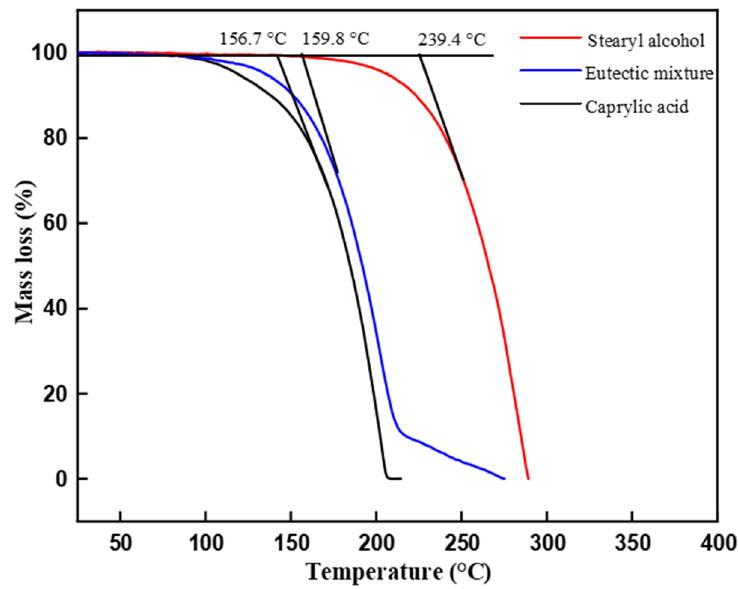
Figure 8. TGA analysis of pure materials and prepared eutectic PCM. Fourier ‐ transform infrared spectroscopy (FT ‐ IR) gives insight into the chemical struc ‐ ture of the eutectic PCM to indicate its chemical stability. The FT ‐ IR spectral data for caprylic acid, stearyl alcohol, and eutectic PCM at 0 cycles and 200 cycles are shown in Figure 9. The spectral data for the pristine materials were similar to the results reported in previous studies [37,38]. The spectral peaks of caprylic acid at 2935 cm − 1 and 2863 cm − 1 indicate O–H and C–H vibration stretching. The spectral peaks at 1712 cm − 1 and 1417 cm − 1 represent C = O and –CH 2 stretching, respectively. The 1239 cm − 1 and 727 cm − 1 show the C–O stretching. The absorption peak at 3340 cm − 1 for stearyl alcohol signifies the –OH stretching vibration. The –CH 2 is represented by 1463 cm − 1 , and C–O appears by 1064 cm − 1 and 727 cm − 1 . The FT ‐ IR results for the pure materials and eutectic PCM depict that the materials are chemically stable and the chemical structure is not varied. The prepared eu ‐ tectic PCM is chemically stable for 200 thermal cycles and no change was evidenced in the chemical structure. The caprylic acid ‐ stearyl alcohol holding good chemical stability makes it a potential candidate for real ‐ time cooling applications.